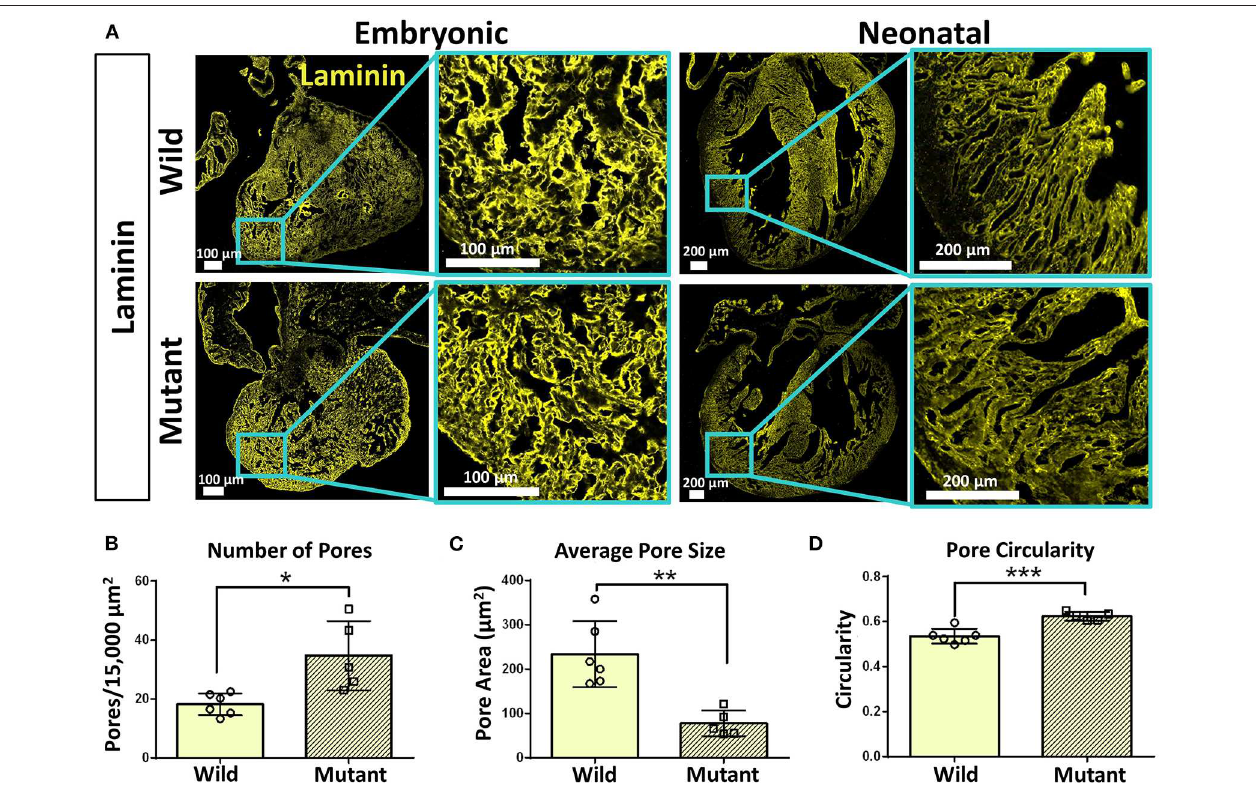
FIGURE 4 | Laminin immunostaining reveals organizational differences between wild type and Nkx2-5 mutant ECM. (A) Laminin (yellow) immunostaining on both embryonic and neonatal wild type and Nkx2-5 mutant mouse hearts. Embryonic scale bars: 100 µ m. Neonatal scale bars: 200 µ m. Laminin staining used Alexa Fluor 647 dye but was pseudo-colored yellow for ease of comparison across graphics. (B) Average number of pores measured per 15,000 µ m 2 area of tissue. (C) Measure of average pore size in µ m 2 across neonatal wild type and mutant laminin staining. (D) Measure of average circularity of neonatal pores, where a circularity of “1” is a perfect circle. For quantification, n = 6 for wild type and n = 5 for mutant hearts. Graphs show mean ± standard deviation with significance * p < 0.05, ** p < 0.01, and *** p < 0.001.